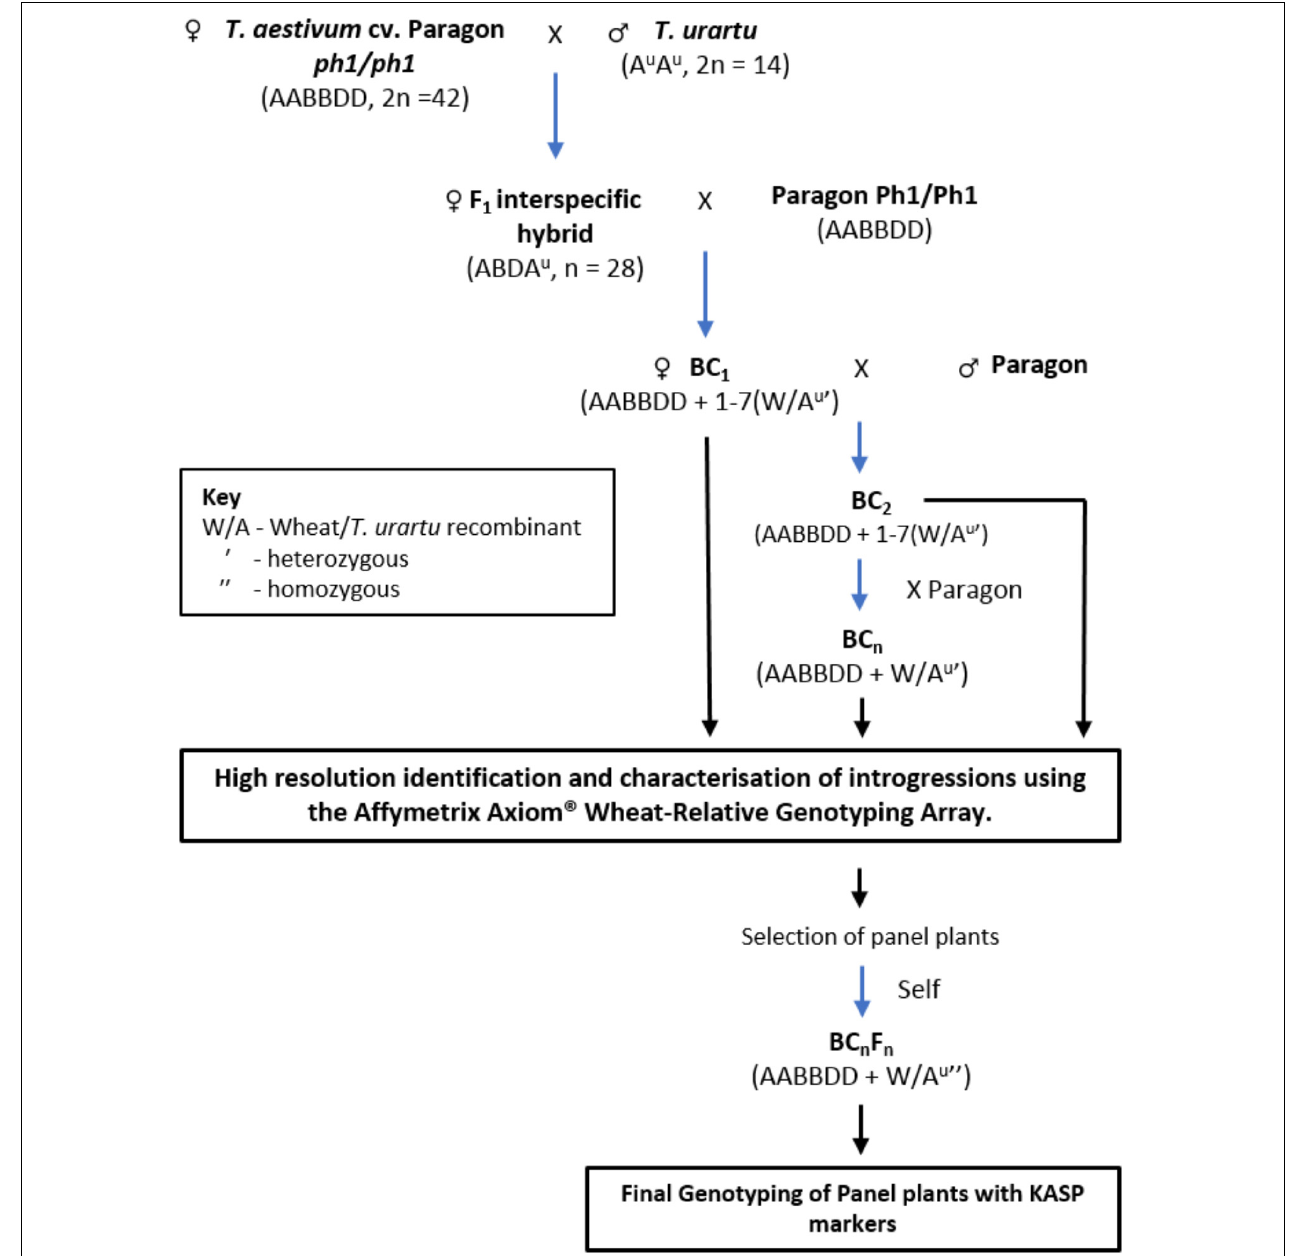
FIGURE 1 | A summary of the crossing program followed to obtain interspecific wheat- Tritcum urartu introgression lines.